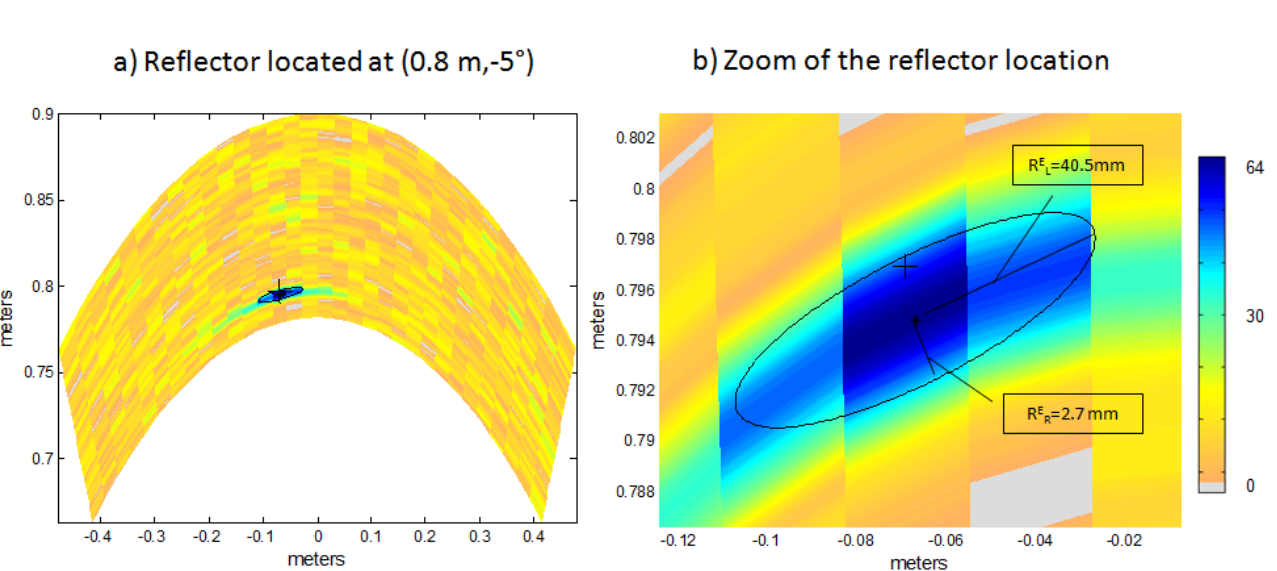
Figure 8. (a) Reflector location estimation with Encoded PA after a single simulation. (b) Zoom of the reflector